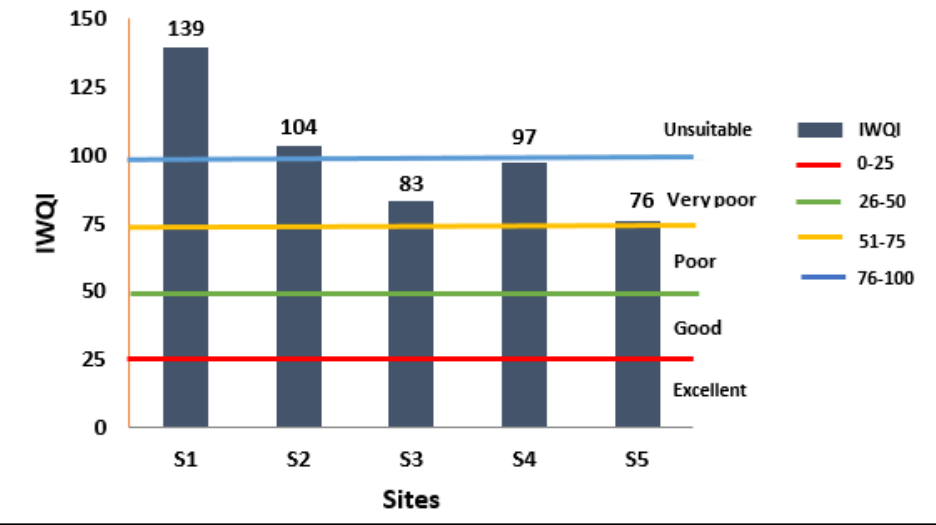
Table 7. Suitability classification for agricultural irrigation from groundwater.